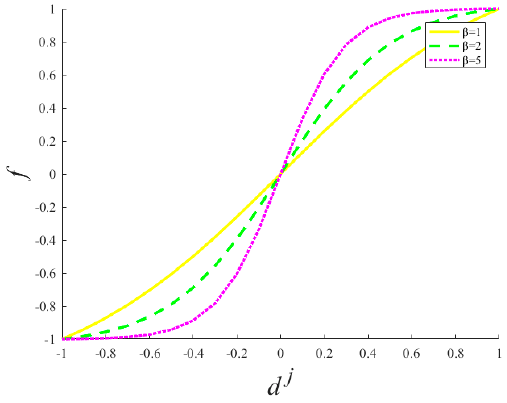
Figure 2. Detail-enhancement function of different parameters.